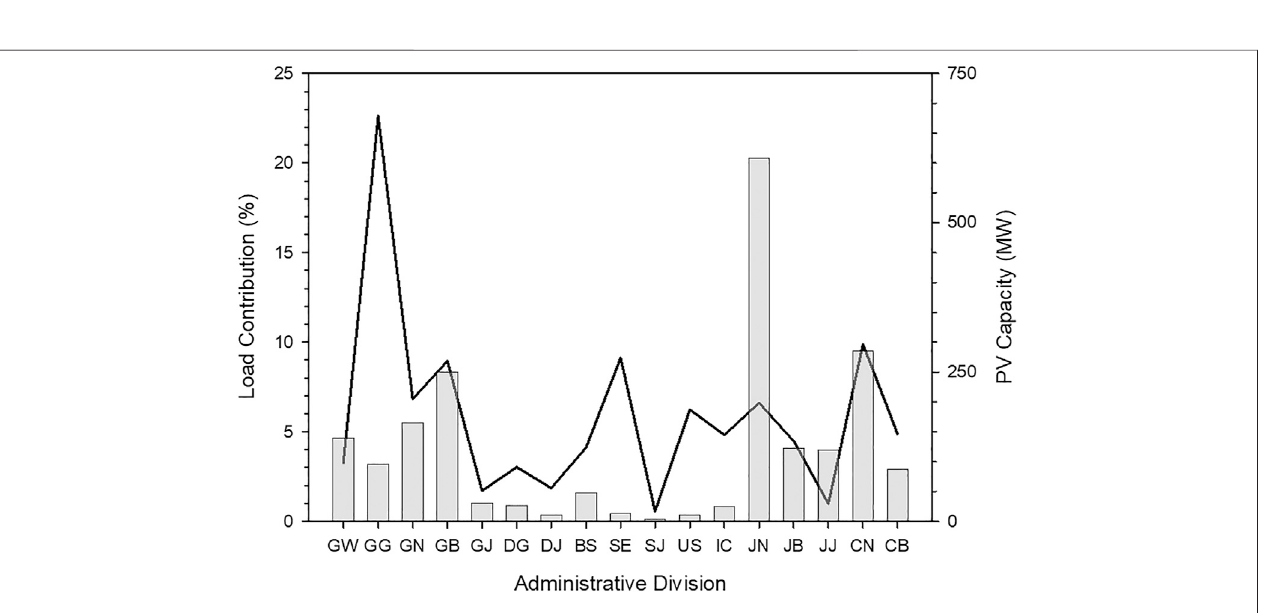
Frontiers in Chemistry |